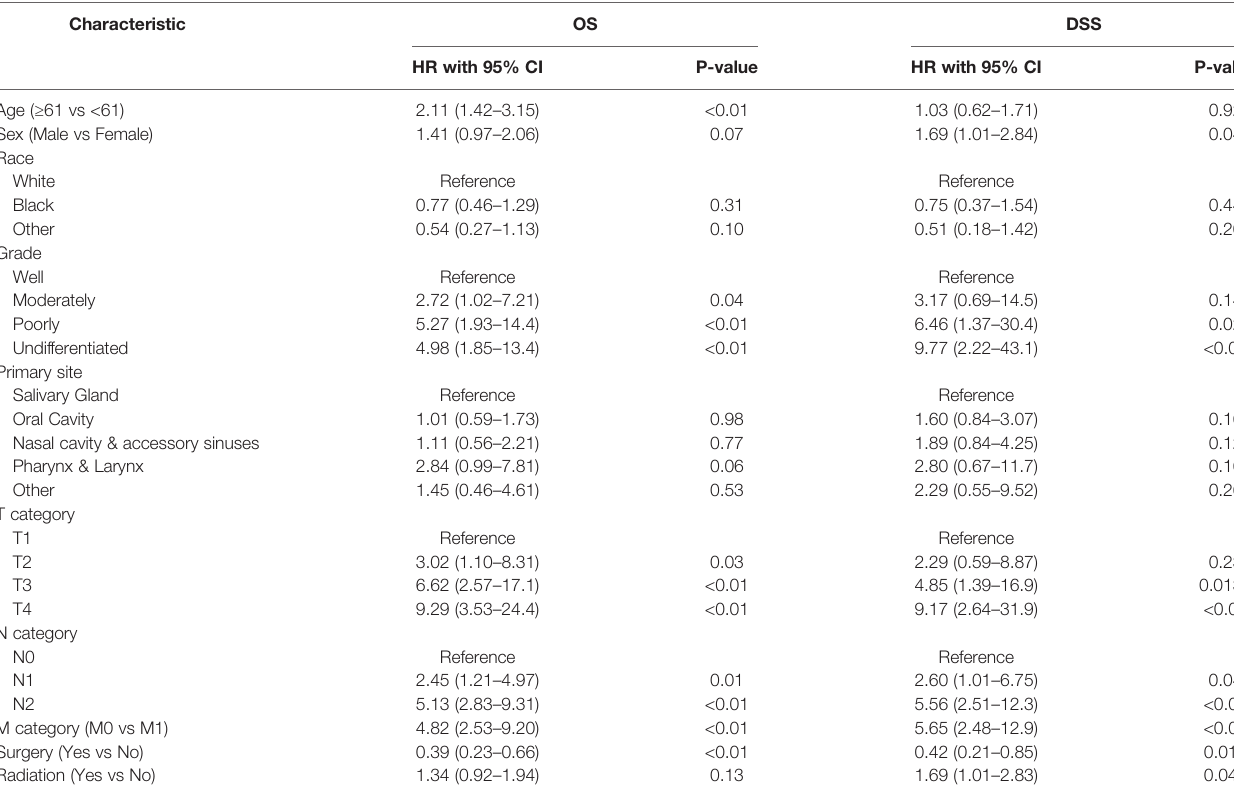
TABLE 2 | Univariate COX regression analysis for OS and